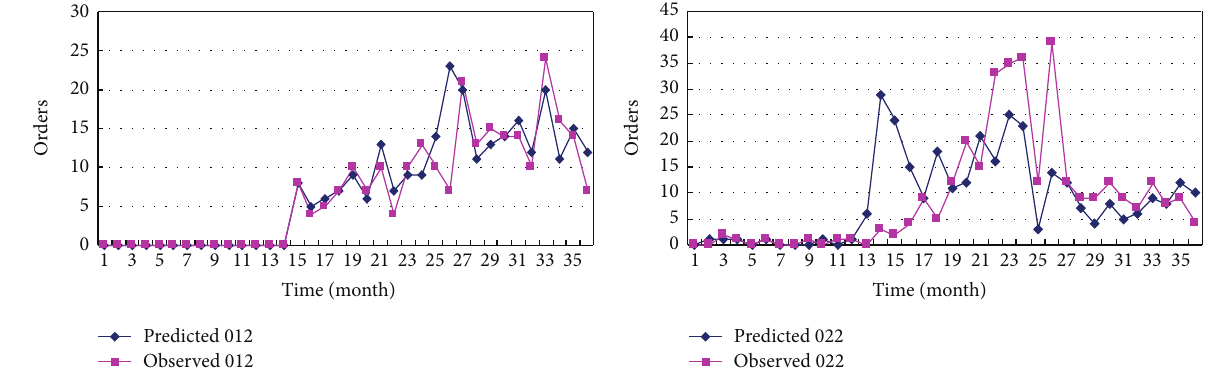
Figure 10: The bulk orders predicted by the logistic model. Table 5: Calculation of seasonal ratios by the logistic